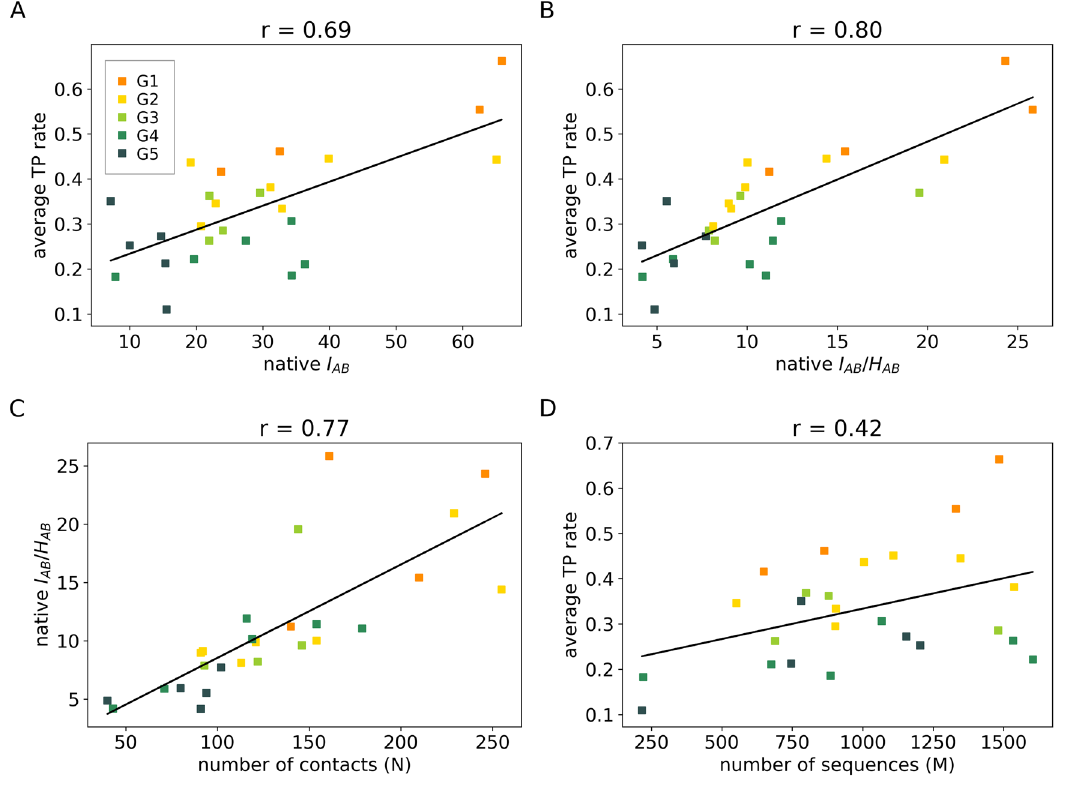
Figure 5. ( A ) Correlation between the true positive (TP) rate of optimized solutions and mutual information (MI) on the interface I AB . ( B ) Correlation between TP rate of optimized solutions and I AB regularized by the joint entropy on the interface, I AB / H AB . ( C ) Correlation between native I AB / H AB and the number of contacts on the interface (N). ( D ) Correlation between TP rate and number of sequences in the alignment (M). Values on the x-axis in A-B were calculated considering the native pairing. TP rates are shown as averages (n = 6) for each system. Systems were colored based on groups G1–5: group 1 is composed by systems with only type-(i) solutions (Fig. 3C and Fig. S3), group 2 by systems with a majority of type-(i) solutions (Fig. 3D and Fig. S4), group 3 by systems with the same proportions of type-(i) and type-(ii) solutions (Fig. 3E and Fig. S5), group 4 by systems with a majority of type-(ii) solutions (Fig. 3F and Fig. S6), and group 5 by systems in which optimized concatenations did not differentiate from the scrambled ones (Fig. 3G and Fig. S7). This figure was generated using matplotlib v3.1.2 (https:// matpl otlib.